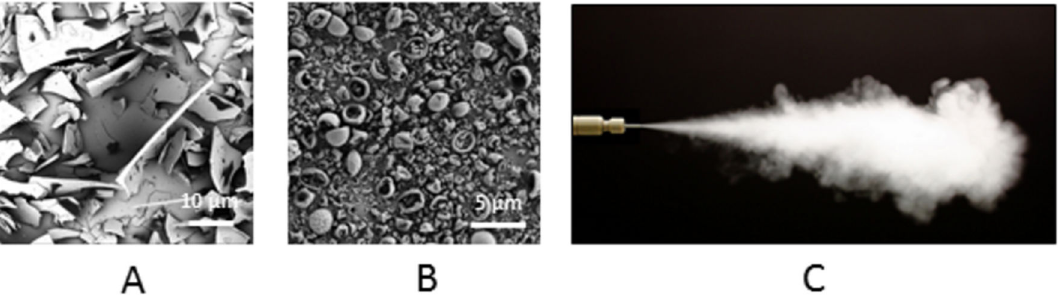
Figure 2. Images of oxytocin particles. Scanning electron micrographs of unprocessed oxytocin and oxytocin loaded carrier particles; (A) unprocessed commercial oxytocin (x 375); (B) oxytocin formulated as an ultrafine dry powder with the glycine-leucine- mannitol carrier (x 5000). (C) Well-dispersed aerosolised plume of ultrafine particles emitted from an insufflator.